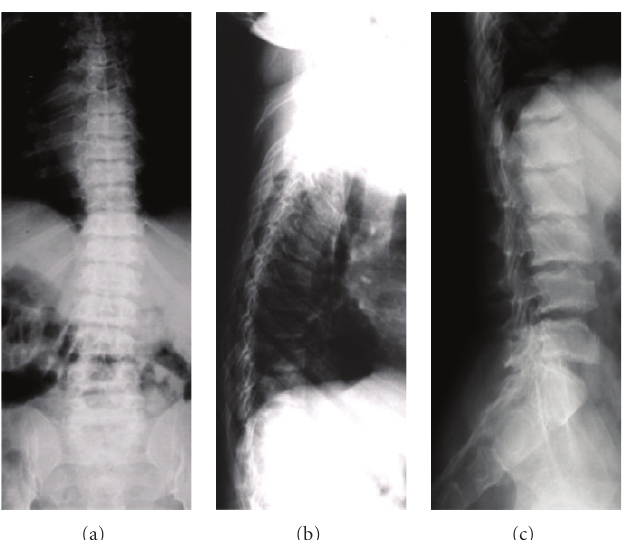
Figure 1: (a) Frontal RX view of the chest depicting bell-shaped chest and decreased height of the trunk. (b) XR lateral view of the thoracic spine depicting varying degrees of platyspondyly with anterior wedging of vertebral bodies. (c) XR lateral view of the lumbar spine with irregularity of the end